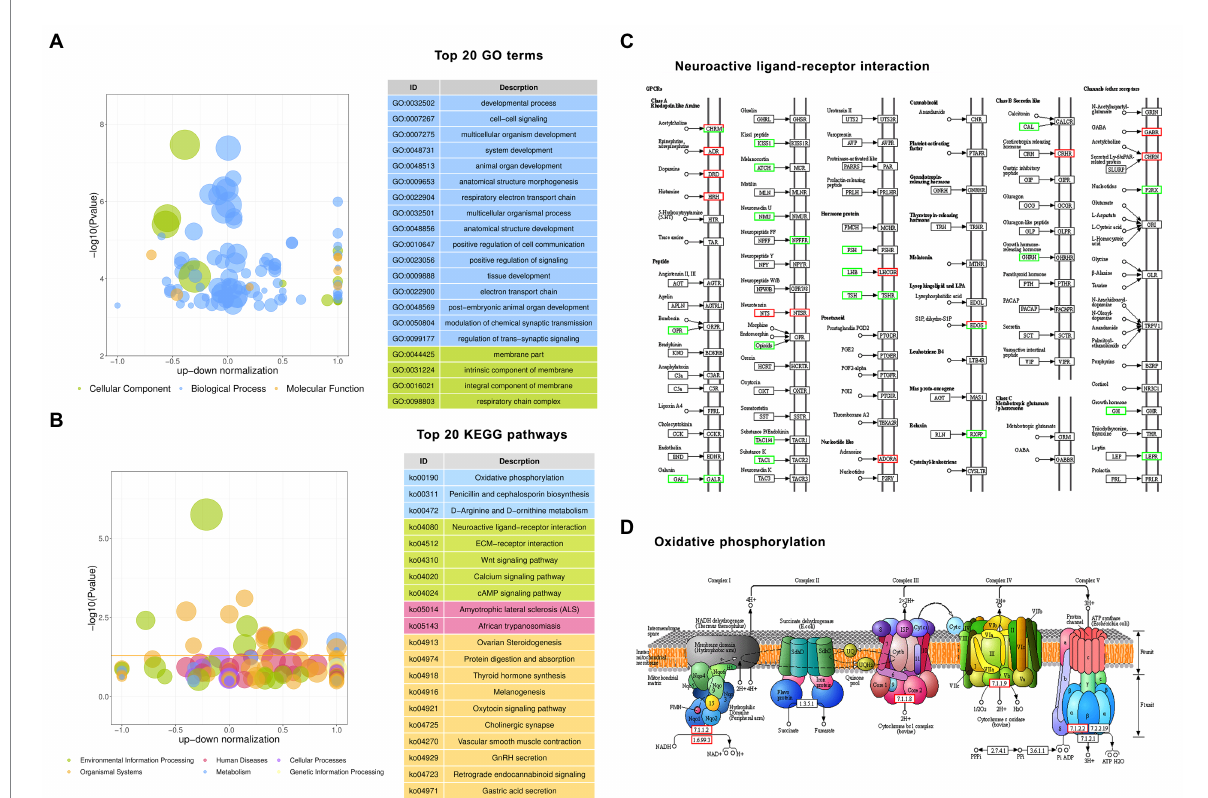
FIGURE 3 Gene Ontology (GO) and Kyoto Encyclopedia of Genes and Genomes (KEGG) enrichment analyses of differentially expressed protein-coding genes. (A) The top 20 enriched GO terms. (B) The top 20 enriched KEGG pathways. (C) The pathway of neuroactive ligand–receptor interaction. (D) The pathway of oxidative phosphorylation. Red boxes are upregulated genes, and green boxes are downregulated genes in GF pigs relative to CG